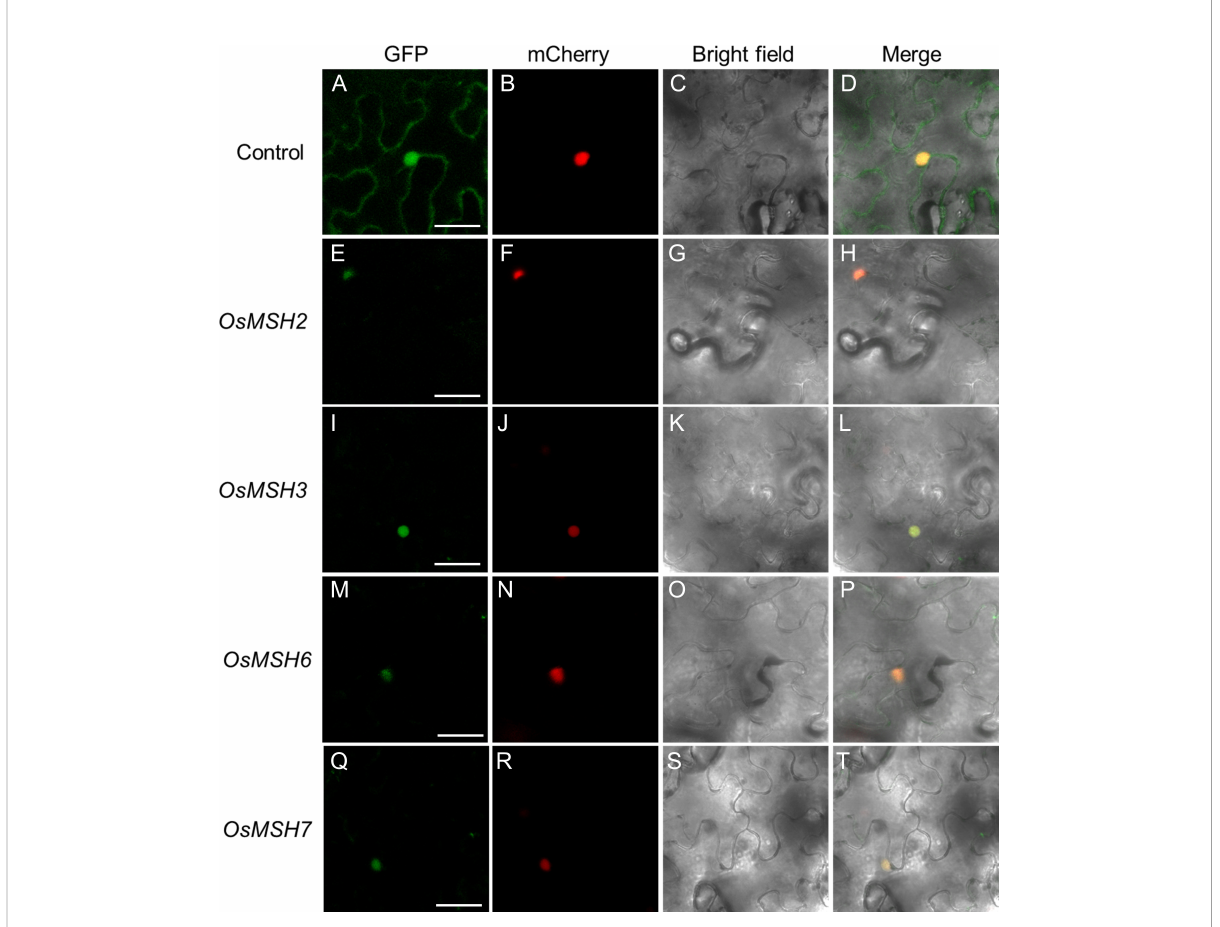
FIGURE 6 Subcellular localization of OsMSH2, OsMSH3, OsMSH6 and OsMSH7. (A) 35S::GFP control vector. (E) 35S::OsMSH2::GFP. (I) 35S:: OsMSH3::GFP. (M) 35S:: OsMSH6::GFP. (Q) 35S:: OsMSH7::GFP. (B – R) AtWRKY25-mCherry: a marker anchored in the cell nucleus. (C – S) Bright fi eld. (D – T) Merged images. Scale bars: 20 m